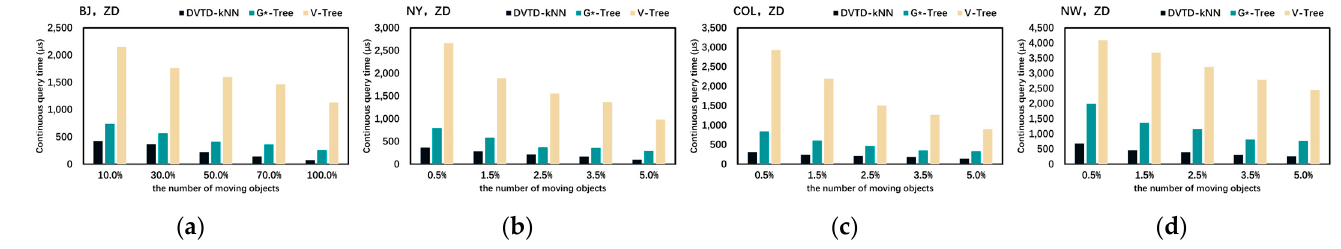
Figure 15. Comparison of query times between baseline algorithms and DVTG-C k NN w.r.t. the number of moving objects. ( a ) Query times on BJ; ( b ) Query times on NY; ( c ) Query times on COL; ( d ) Query times on NW.